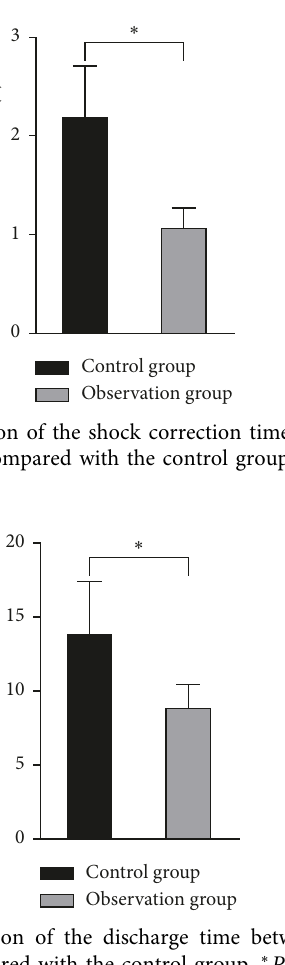
Figure 5: Comparison of the intraoperative bleeding volume between the two groups. Note: compared with the control group, P 0 . 05. ∗ <